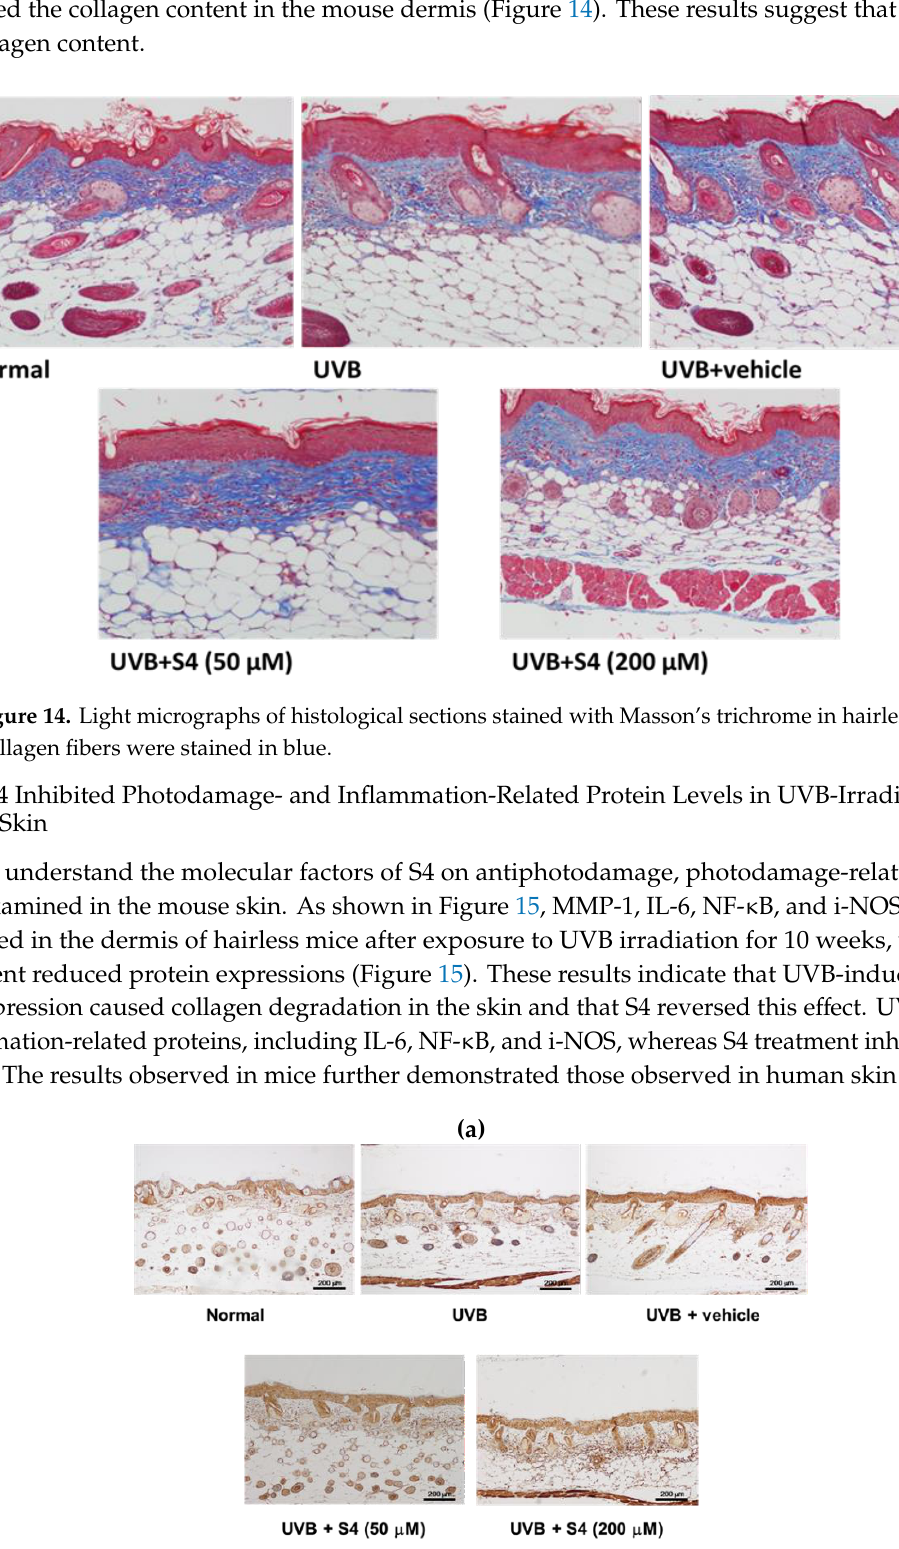
(c) (d) Figure 15. Immunohistological staining of skin slices for (a) MMP-1, (b) IL-6, (c) NF-κB and (d) i-NOS in the hairless mouse skin after chronic UVB exposure and S4 treatment.